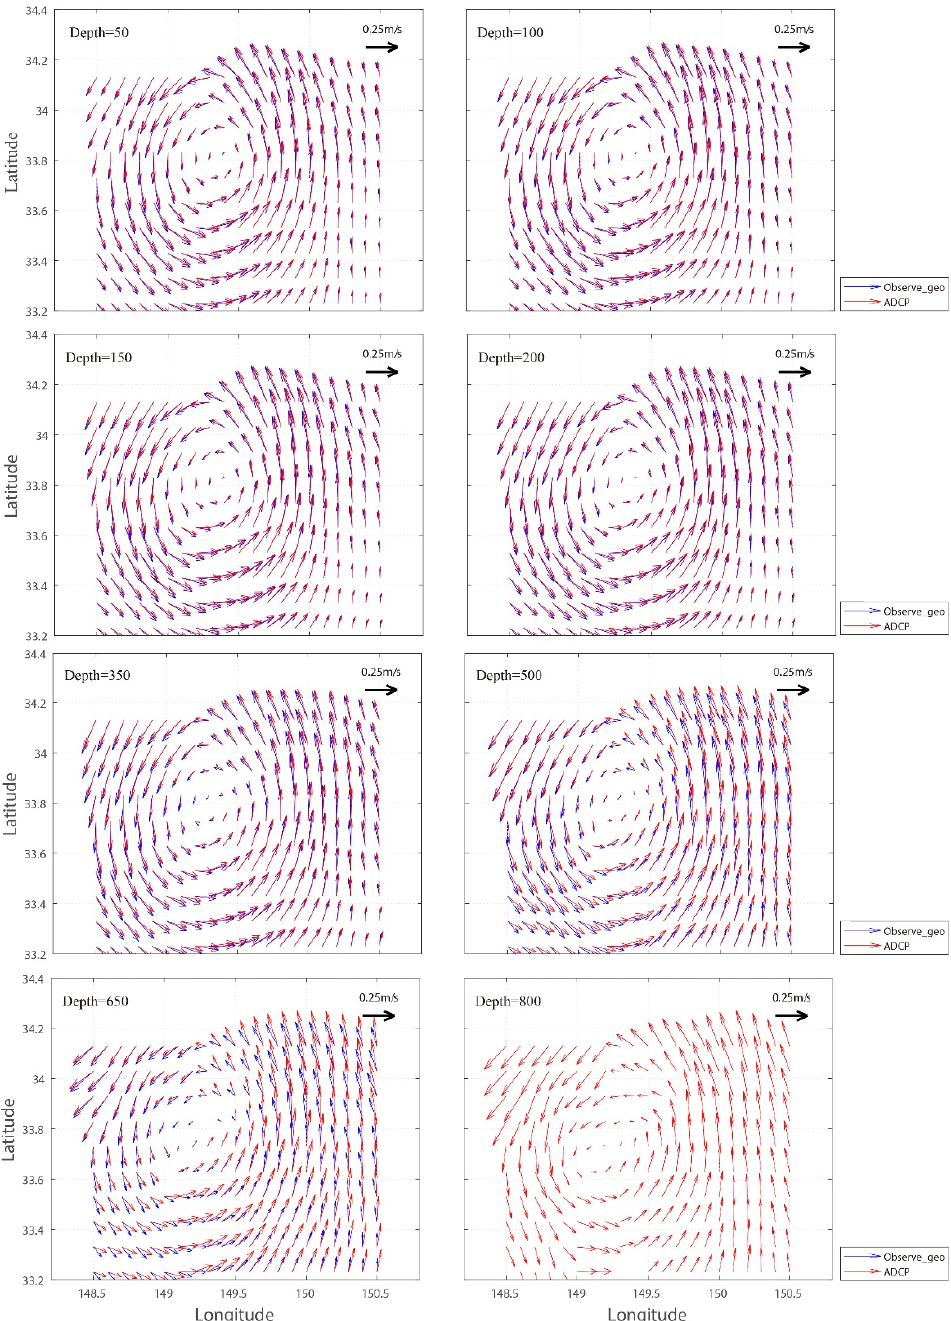
Figure 11. Actual and geostrophic velocities at some specific depth levels. The blue arrows are geostrophic velocities calculated by the MVP T/S data; the red arrows are the actual velocities measured by the ADCP after data interpolation.